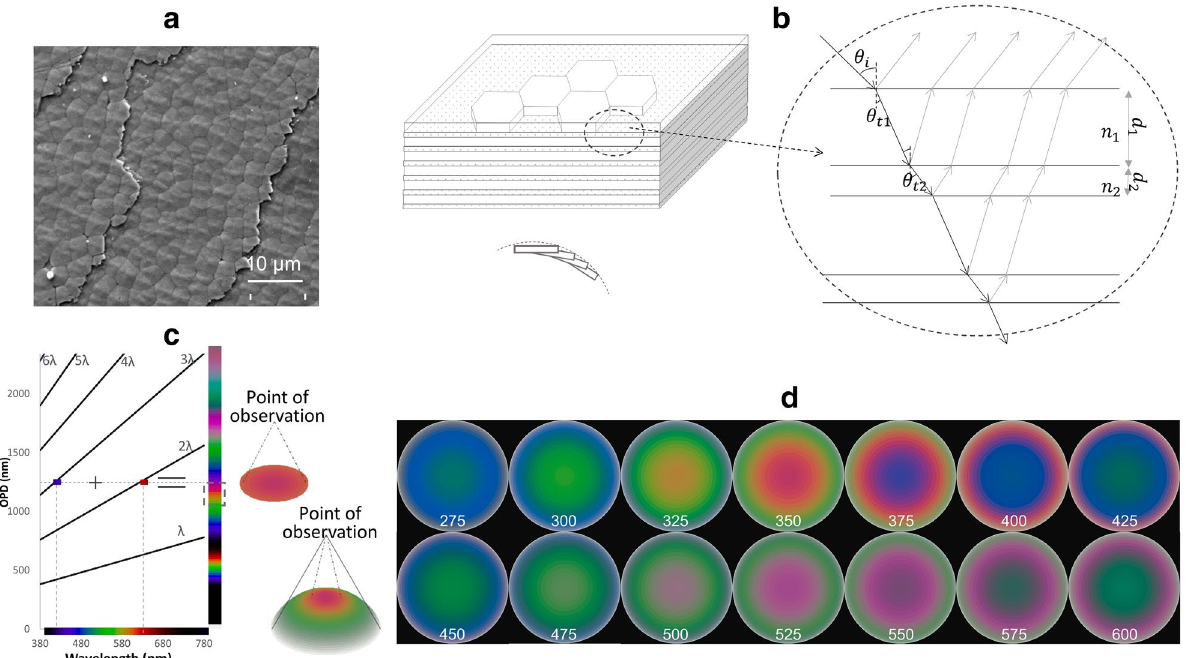
Figure 1. ( a ) An example of nacre’s layered structure with its surface under scanning electron microscope. ( b ) Cross-sectional illustration of aragonite–conchiolin double layers and the staggering of these layers due to surface curvature. ( c ) Quick estimation of repetitive double layers’ interference color and color pattern following Bragg’s Law. ( d ) Interference pattern simulations on a round pearl with aragonite layer thickness varying from 275 to 600